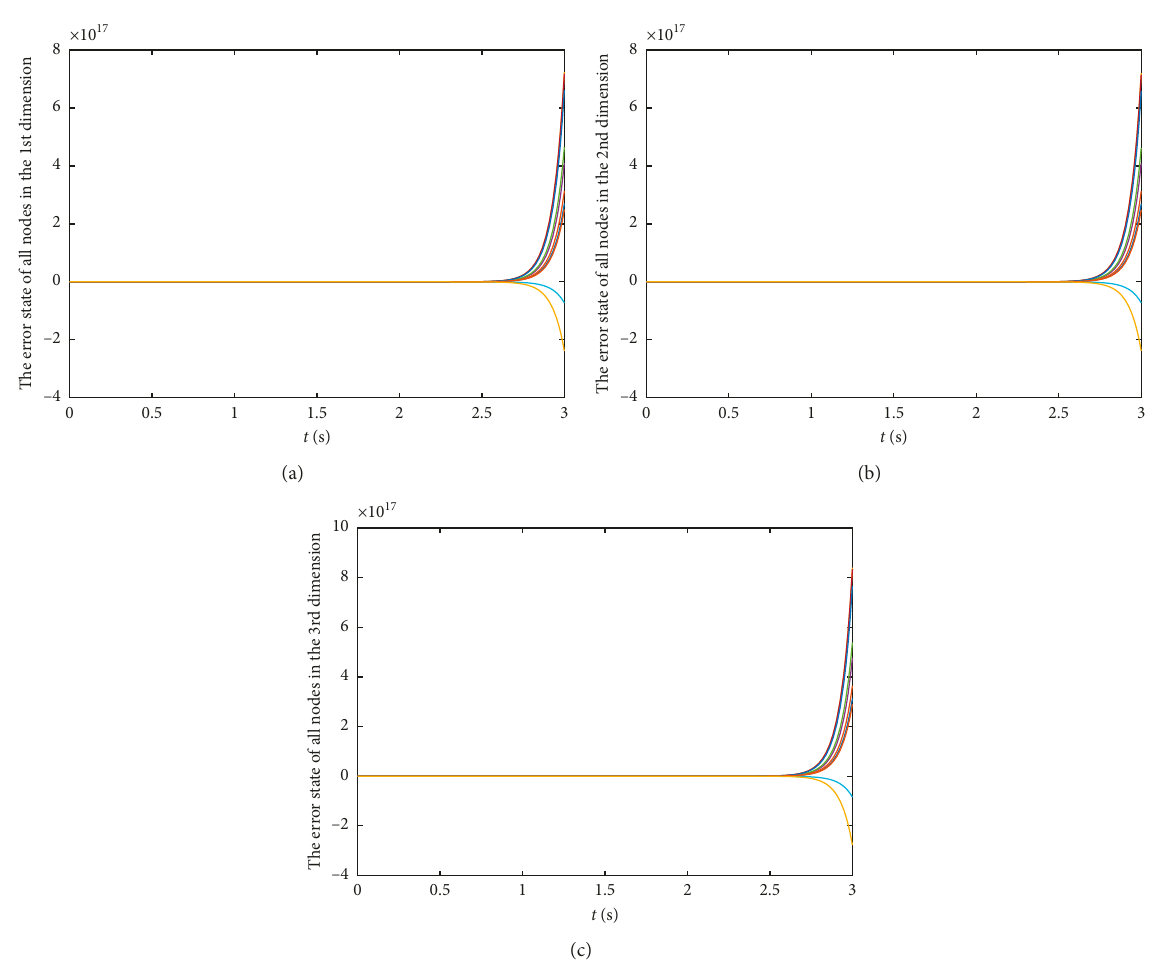
Figure 1: The state of all nodes in different dimensions without the controller.